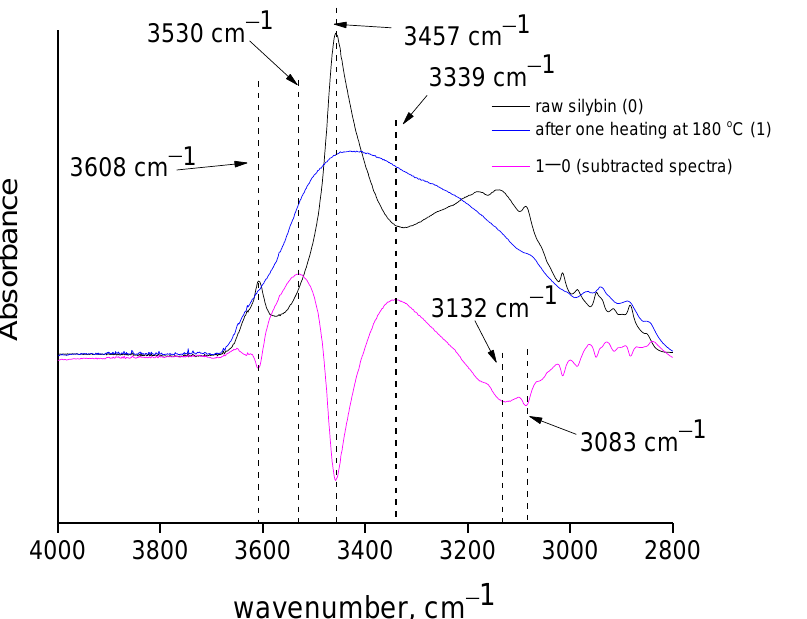
Figure 5. FTIR spectra of raw and heated silybin samples and their subtracted spectrum in the region 2800–4000 cm −1 .